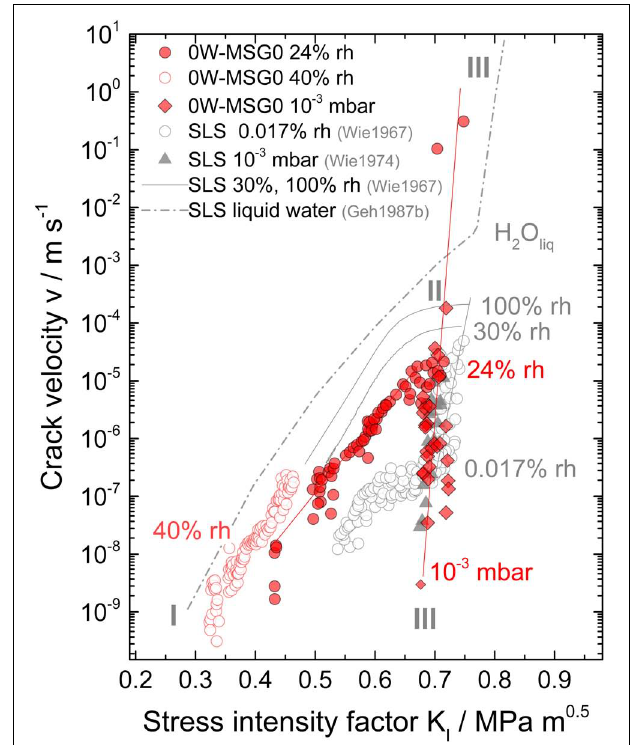
FIGURE 1 | Crack velocity, v , versus stress intensity factor, K I , of the nominal dry microscope slide glass (red) compared to literature data on similar glasses (gray, Table 1 ). Red lines are best fits of Eq. 2. Full red circles: 24% rh, open red circles: 40% rh, full red diamonds: 10 − 3 mbar. Gray open circles: Microscope slide glass at 0.017% rh (Wiederhorn, 1967), gray triangles: Microscope slide glass at 10 − 3 mbar (Wiederhorn et al., 1974), solid gray lines: (Wiederhorn, 1967), gray dash-dot curve: Float glass in liquid water (e.g. Gehrke et al.,